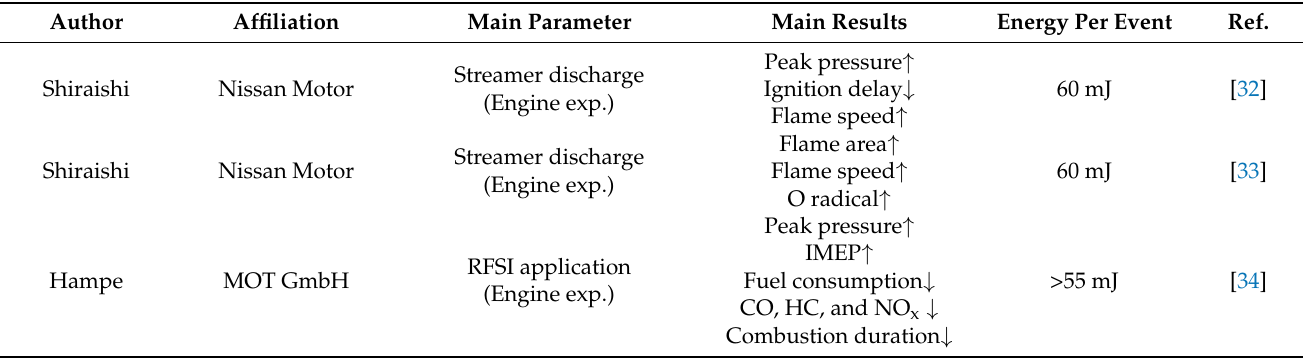
Table 3. Summary of effect of corona ignition on